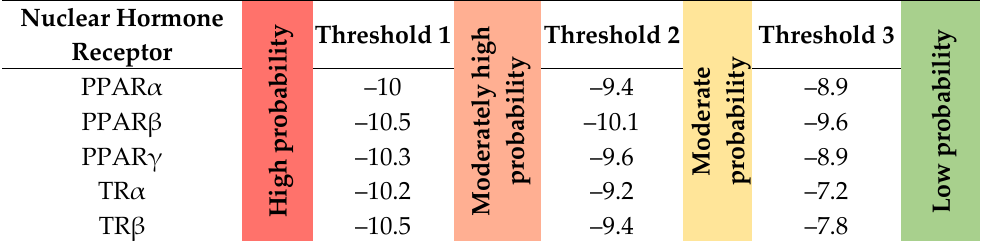
Table 2. Threshold values of binding free energies for PPARα, PPARβ, PPARγ, TRα, TRβ. Nuclear